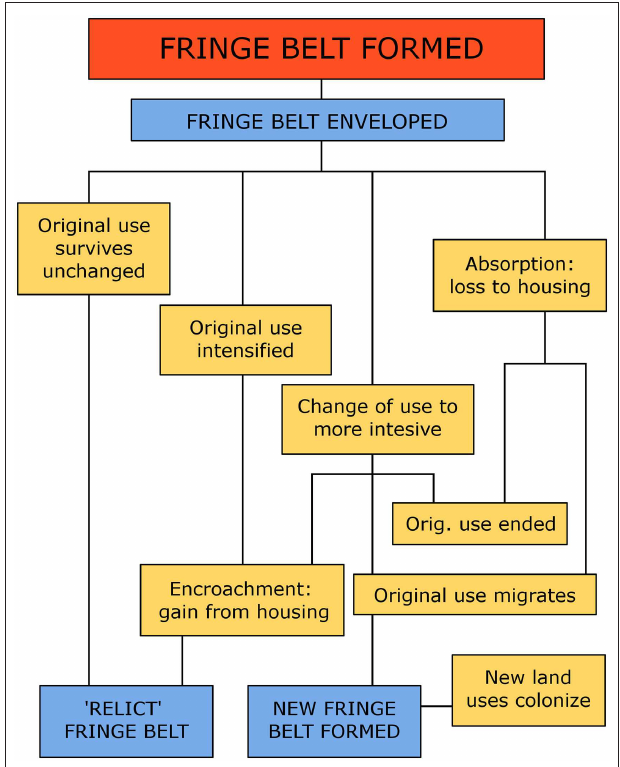
FIGURE 8 | Fringe belt flow chart (after Conzen, 2009: Figure 2